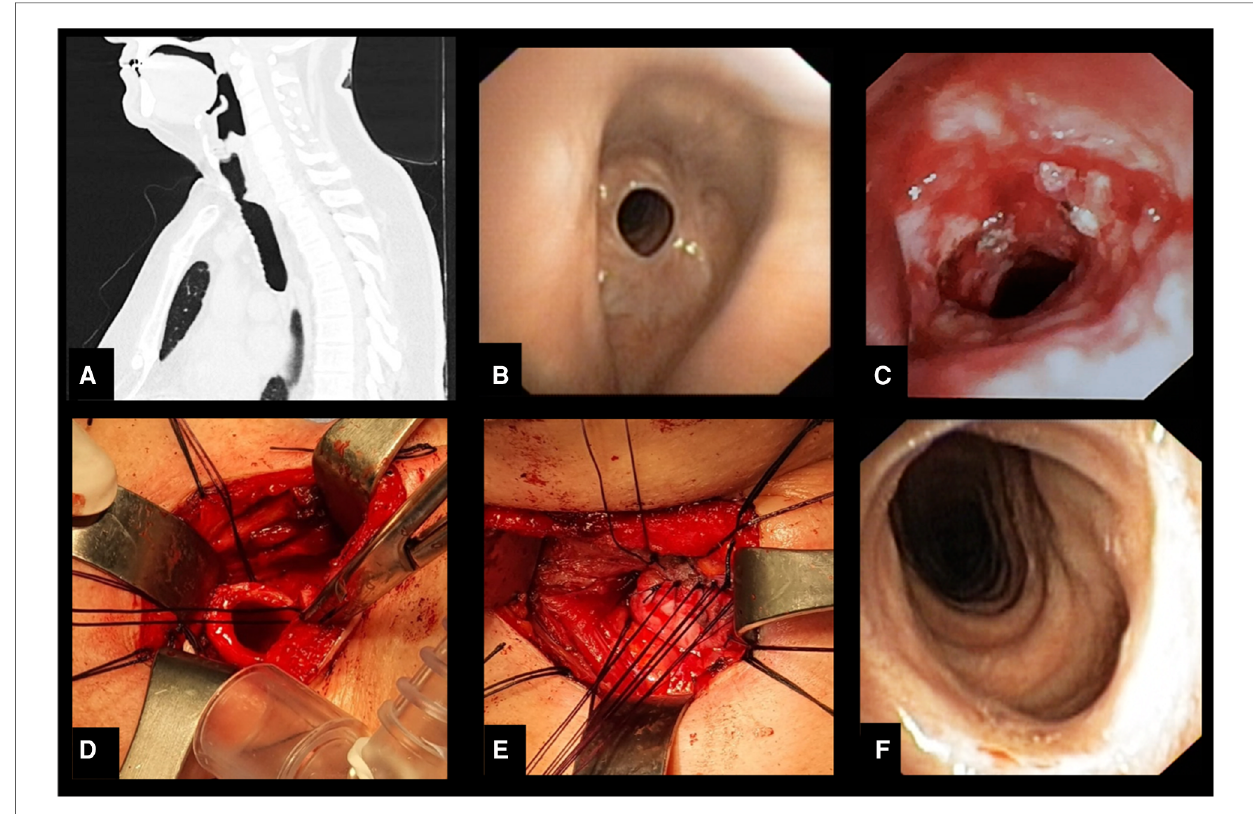
FIGURE 2 ( A ) Sagittal computed tomography image showing stenosis of the upper third of trachea. ( B ) Bronchoscopic appearance of the stenosis. ( C ) Endoscopic appearance of the recurrence of stenotic tracheal segment after endoscopic treatment with laser and dilation. ( D ) Intraoperative photo after resection of the stenotic tracheal segment. ( E ) Intraoperative appearance of the tracheal anastomosis. ( F ) Bronchoscopic appearance 3 months after surgery.